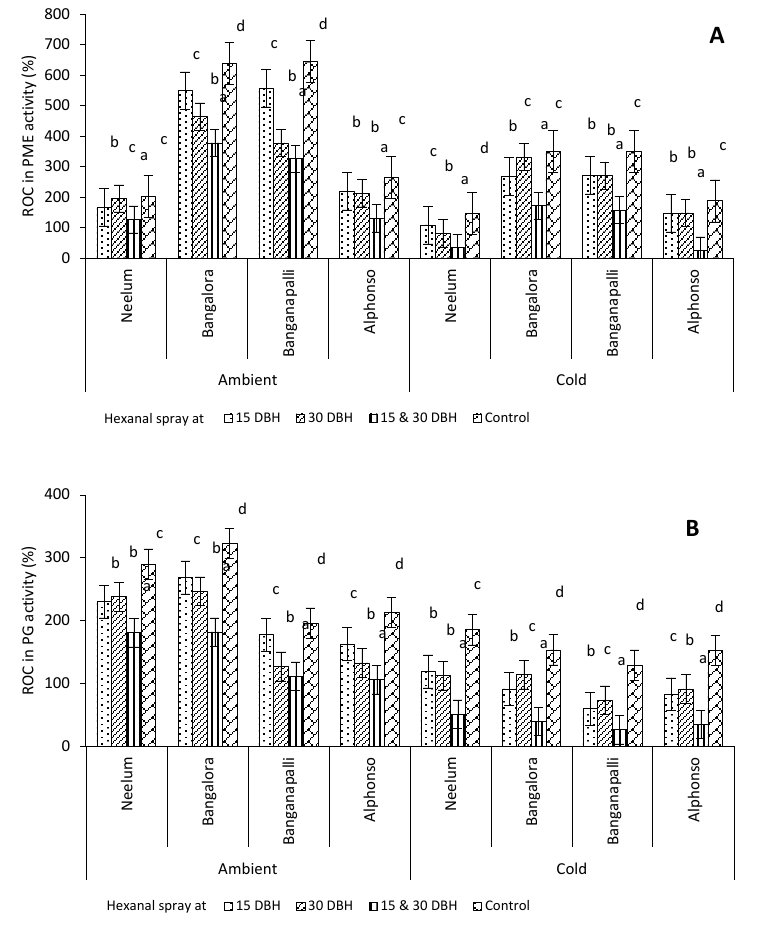
Figure 7. Percentage rate of change in the PME ( A ) and PG activity ( B ) of hexanal-treated and control mango fruits stored under ambient and cold conditions. The vertical bars in the columns represent the standard error of four replicates. Columns with different and the same letters indicate statistical significance and non-significance, respectively ( p = 0.05). DBH — Days before harvest; ROC — Rate of change.